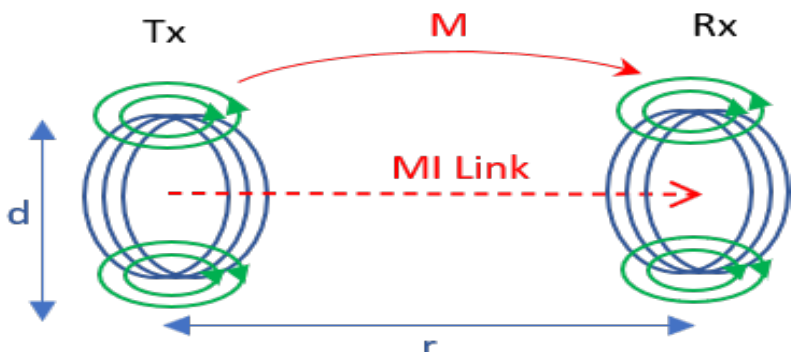
Figure 2. MI communication model for single hop